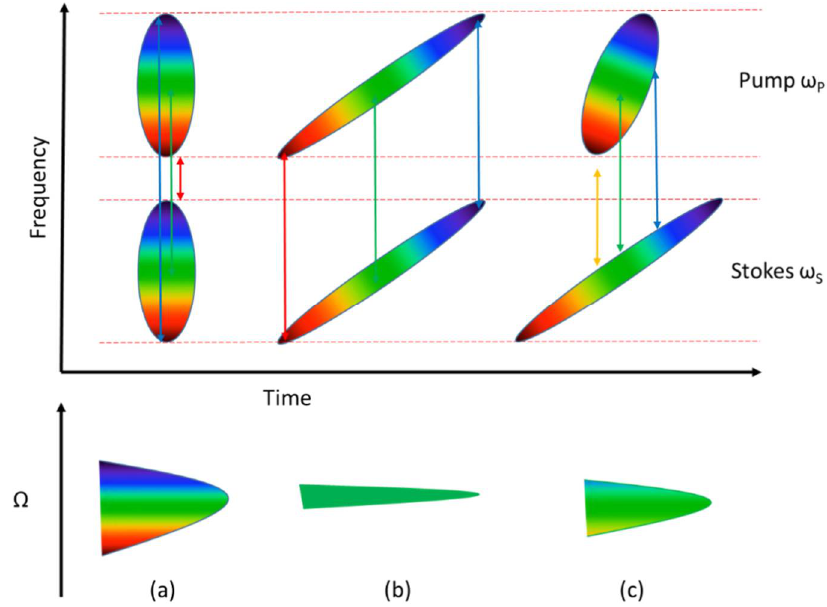
Figure 2. Coherent Raman excitation with ( a ) FTL laser pulses, ( b ) laser pulses with the same chirp, ( c ) laser pulses with different chirps. Ω is the vibration frequency given by Ω = ω p − ω s .